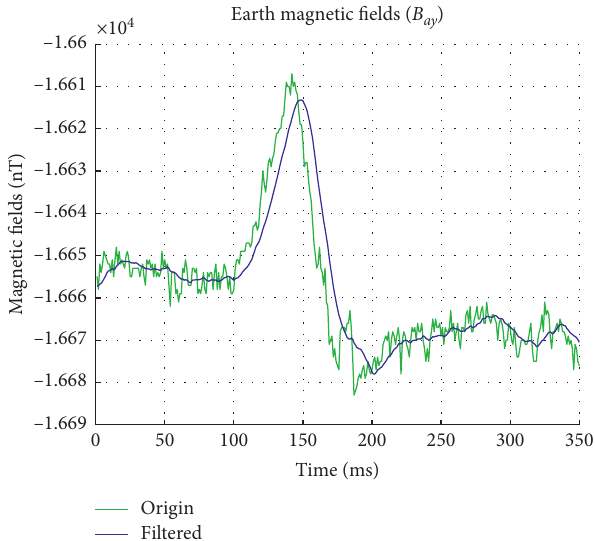
Figure 6: Distorted Earth’s magnetic field when a vehicle is passing